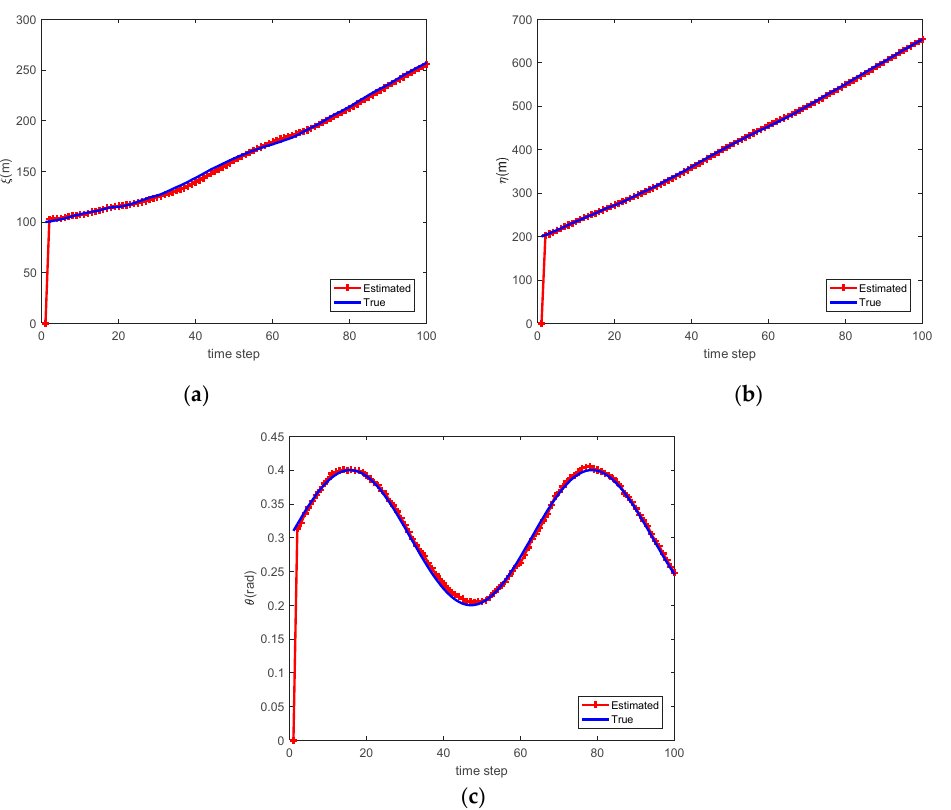
Figure 4. Estimate of ( a ) relative translation in x-axis ( b ) relative translation in y-axis ( c ) relative orientation.